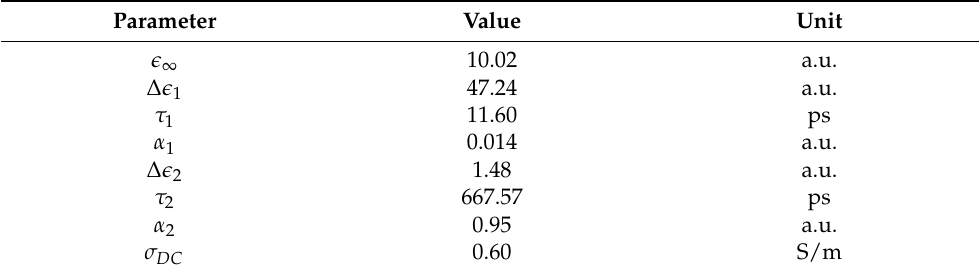
Table 1. Cole–Cole parameters used for modeling the dielectric response of pituitary tumors. Parameter Value